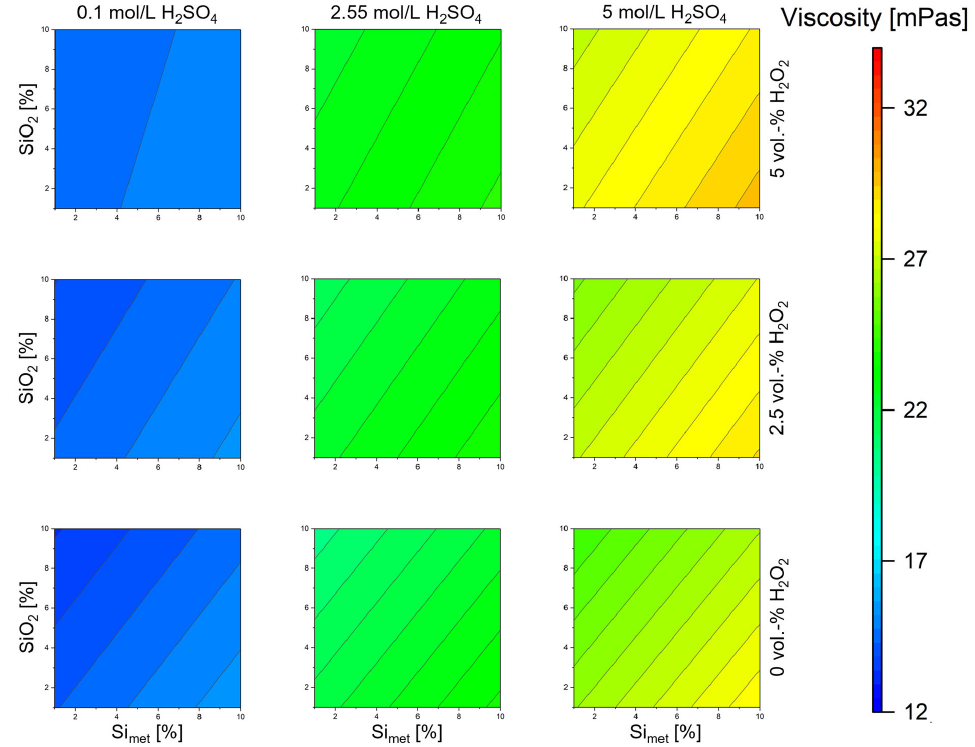
Figure 8. 4D contour plot for the change in viscosity as a function of Si met , SiO 2 , H 2 SO 4 and H 2 O 2 concentration in the leaching solution at an S/L ratio of 50 g/L and a leaching temperature of 80 °C. At maximum temperature (80 °C) and a high S/L ratio (100 g/L), the maximum values for the viscosity of the pregnant leaching solution can be achieved (see Figure 9). At high acid and H 2 O 2 concentrations as well as high silicon contents, a broad range is shown in which viscosities of more than 33 mPas appeared. Furthermore, it can be seen that even at lower H 2 O 2 contents, a significant increase in viscosity can be observed.